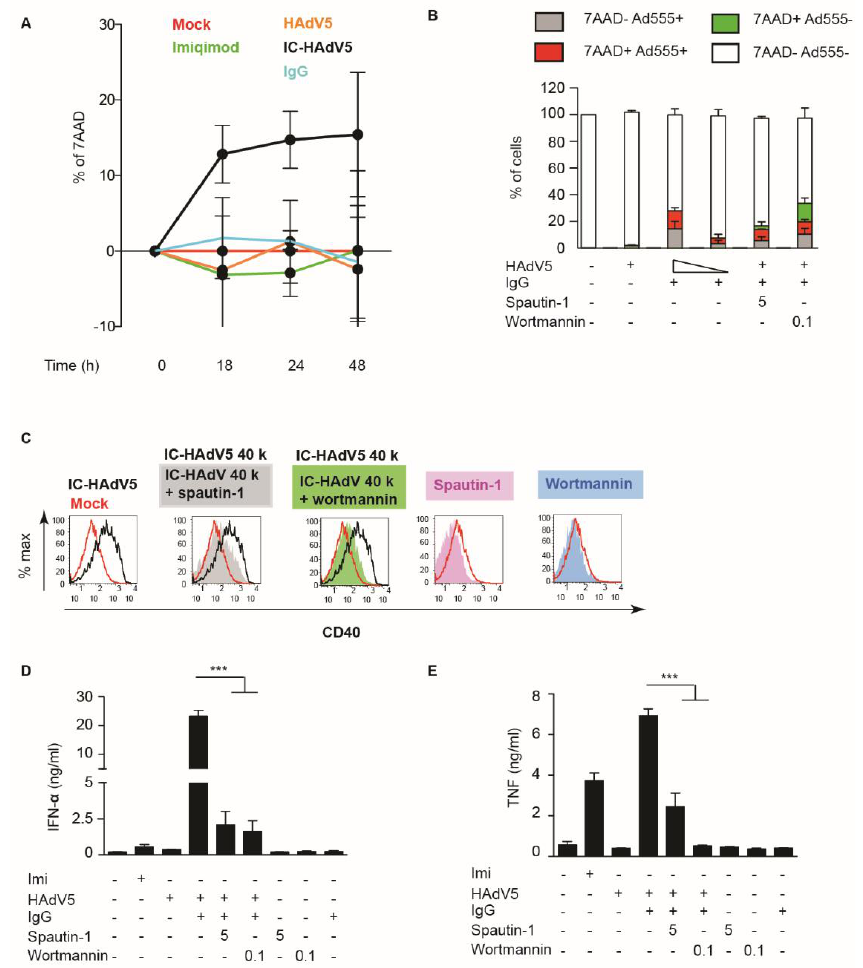
Figure 4. IC-HAdV5 induced loss of cell membrane integrity. ( A ) pDCs were incubated with IgG, HAdV5, and IC-HAdV5 and cell membrane integrity was assessed by intercalation of 7AAD into cellular DNA from 0 to 48 h. ( B ) pDCs were pre-treated with spautin-1 (5 μM) or wortmannin (0.1 μM) for 2 h, then were incubated with HAdV-C5-Alexa555-, IC-HAdV-555 (40,000 or 20,000 pp/cell), or IgG and assayed by flow cytometry at 18 h. The quadrants were set for 7AAD- Ad555- (white), 7AAD- Ad555 + (grey), 7AAD + Alexa555 + (red), and 7AAD + Ad555- (green). The percentage of each subpopulation at each condition is depicted in the histogram. These assays were performed in three donors with similar results. ( C ) pDCs were pre-treated with spautin-1 or wortmannin for 2 h then were incubated with IgG, HAdV5, or IC-HAdV5 in 18 h. CD40 surface expression was detected by flow cytometry. These assays were performed in three donors, with similar results. ( D , E ) pDCs were pre-treated with spautin-1 or wortmannin and then were incubated with IgG, HAdV5, or IC-HAdV5 in 18 h. IFN-α ( D ) and TNF secretion ( E ) were quantified by ELISA. Experiments were carried out in three donor experiments. p values were derived from t -tests. *** corresponds to p < 0.0001, respectively.